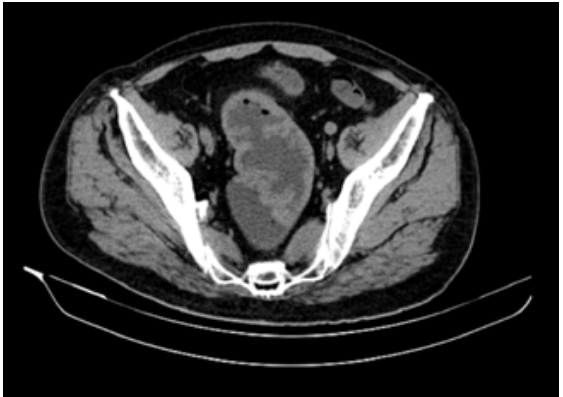
Figure 2. Tumoral mass identified at colonoscopy.